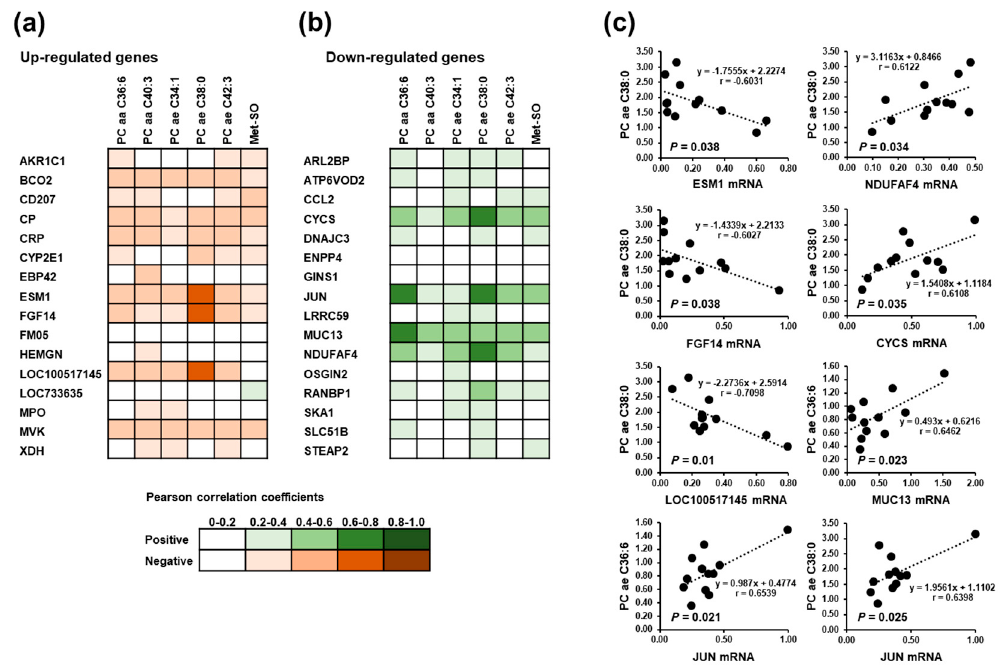
Figure 4. Pearson correlation coefficients from correlation analysis between significantly altered plasma metabolites and the most strongly up-regulated ( a ) and down-regulated ( b ) hepatic genes in the suckling piglets. ( c ) Linear regression for the significant correlations.